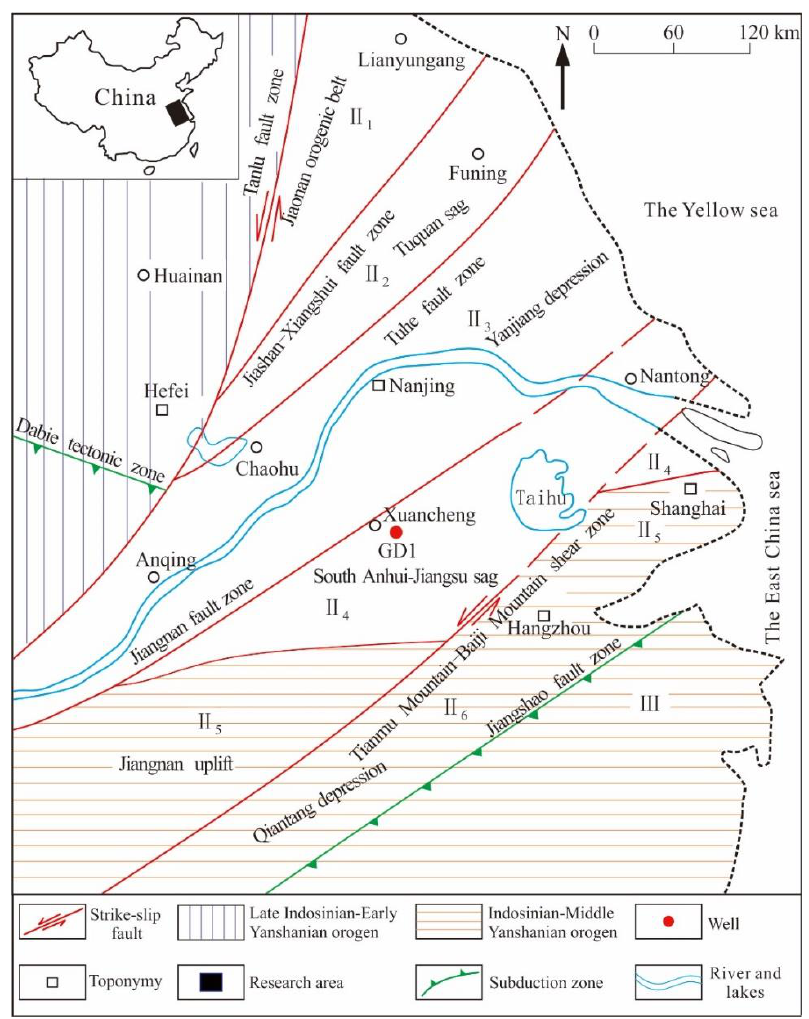
Figure 1. Location of the study area showing regional tectonic profile of the Lower Yangtze area and the location of the sampling well.